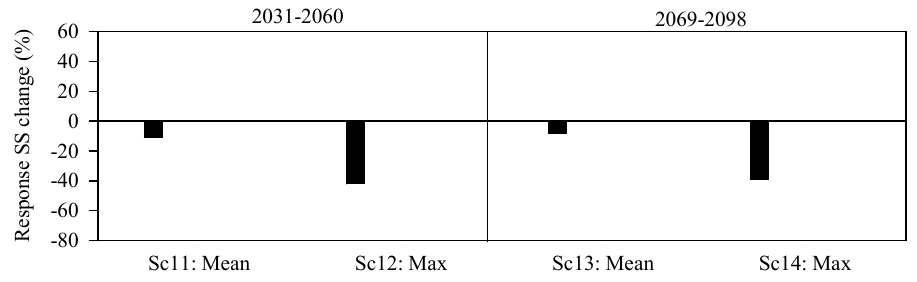
Figure 6. Response of suspended sediment yield to combined changes in temperature, rainfall and CO 2 concentration based on the scenarios defined in Table 1. Sc11: T + mean 2031–2060 °C, P–mean 2031%–2060%, CO 2 550; Sc12: T + max 2031–2060 °C, P–mean 2031%–2060%, CO 2 550; Sc13: T + mean 2069–2098 °C, P–mean 2069%–2098%, CO 2 660; Sc14: T + max 2069–2098 °C, P–max 2069%–2098%, CO 2 660.